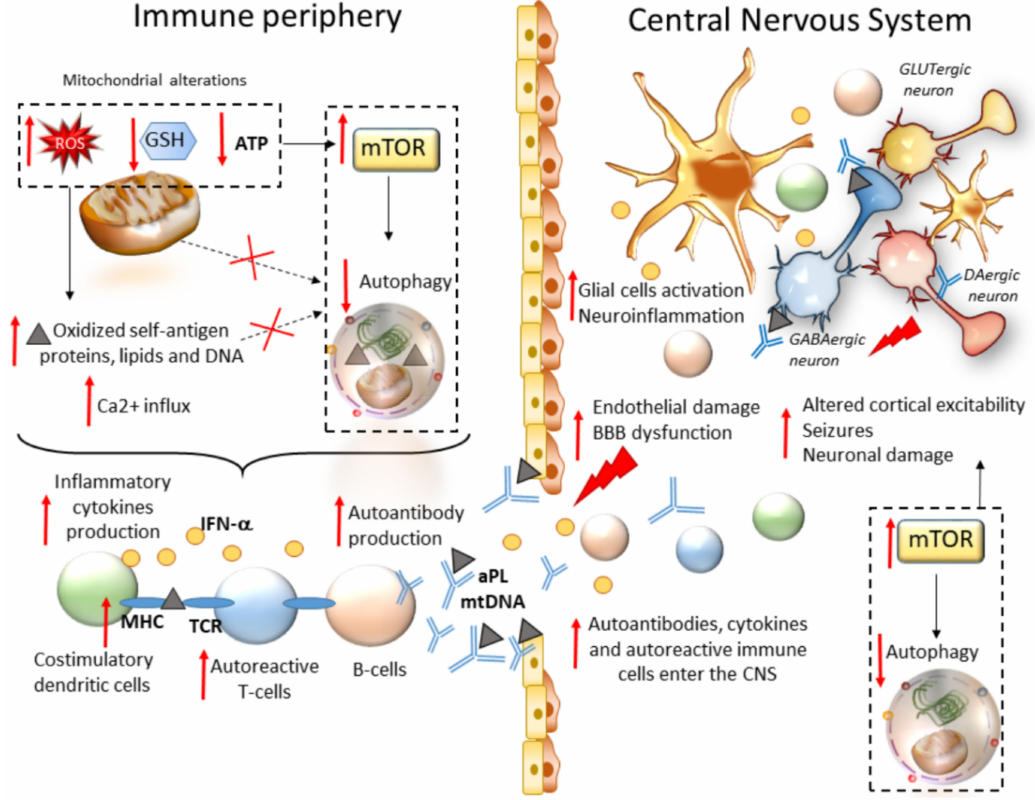
Figure 2. mTOR-dependent seizure development in autoimmune systemic disorders. Within peripheral immune cells, mitochondrial alterations lead to chronic oxidative stress (production of reactive oxygen species (ROS)) along with a concomitant depletion of antioxidant factors (gluthatione, GSH). This promotes oxidation of self-antigen proteins, lipids, and DNA, along with calcium (Ca 2 + ) influx and the release of highly di ff usible oxidative and inflammatory factors, which are spread to other intracellular organelles and through the bloodstream. At the same time, redox imbalance induces mTOR activation and autophagy impairment, eventually leading to impaired removal of oxidized self-antigens and mitochondria, production of inflammatory cytokines by costimulatory dendritic cells, increased stability of major histocompatibility molecules (MHC) on dendritic cells, subsequent activation of autoreactive T cells and production of autoantibodies by B cells. Autoantibodies, activated immune cells, and proinflammatory cytokines are spread through the bloodstream, and they reach the CNS where they produce endothelial damage and disruption of the blood–brain barrier (BBB). Within the brain milieu, these factors, coupled with mTOR hyperactivity and autophagy, impairment promote a chain of events consisting of neuroinflammation through activation of glial cells, altered cortical excitability, and eventually neuronal